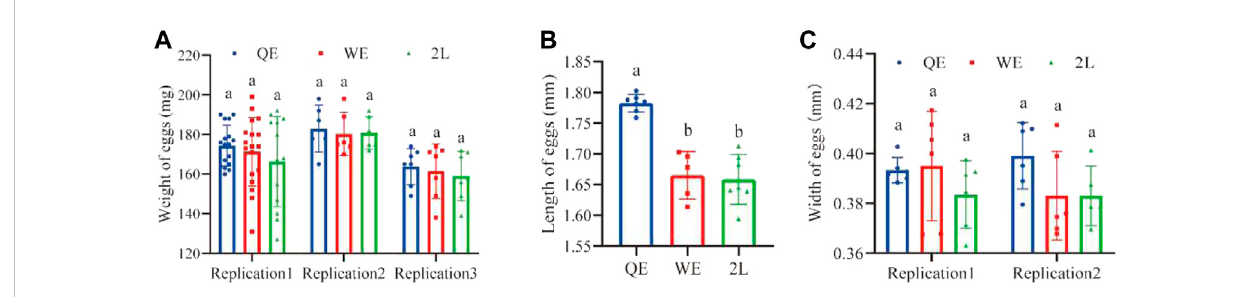
FIGURE 4 (A) Theweight, (B) length,and (C) widthofeggslaidbyrearedqueenswithinthethreegroups(weightofeggs:replication1, n =16,18,13forQE,WE, 2L,respectively;replication2, n =5,6,6forQE,WE,2L,respectively;replication 3, n =7forQE,WE,2L.Lengthofeggs: n =7,5,7forQE,WE,2L.Widthof eggs: replication 1, n = 6, 6, 6 for QE, WE, 2L, respectively; replication 2, n = 6, 6, 5 for QE, WE, 2L, respectively).